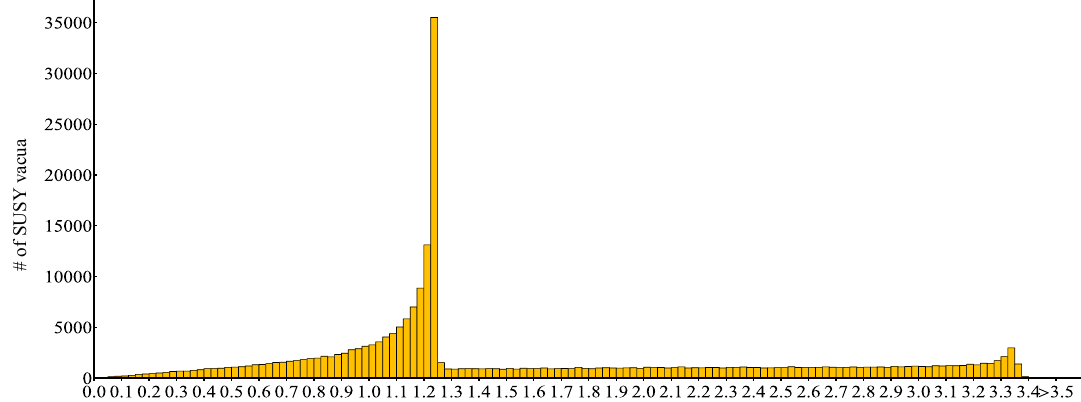
q at SUSY AdS vacua in the isotropic moduli space. m 2 R 2 light AdS